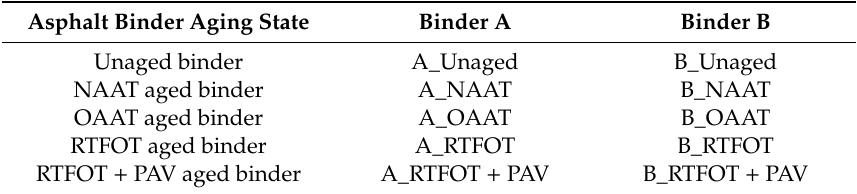
Figure 1. Sample preparation and nitrogen atmosphere oven aging test (NAAT) procedure: ( a ) example of thin-film sample considered in NAAT and ambient atmosphere oven aging test (OAAT) aging procedures, ( b ) set of holder pan filled with thin-film asphalt binder samples, ( c ) the desiccator is filled with nitrogen gas, and ( d ) desiccator filled with nitrogen.